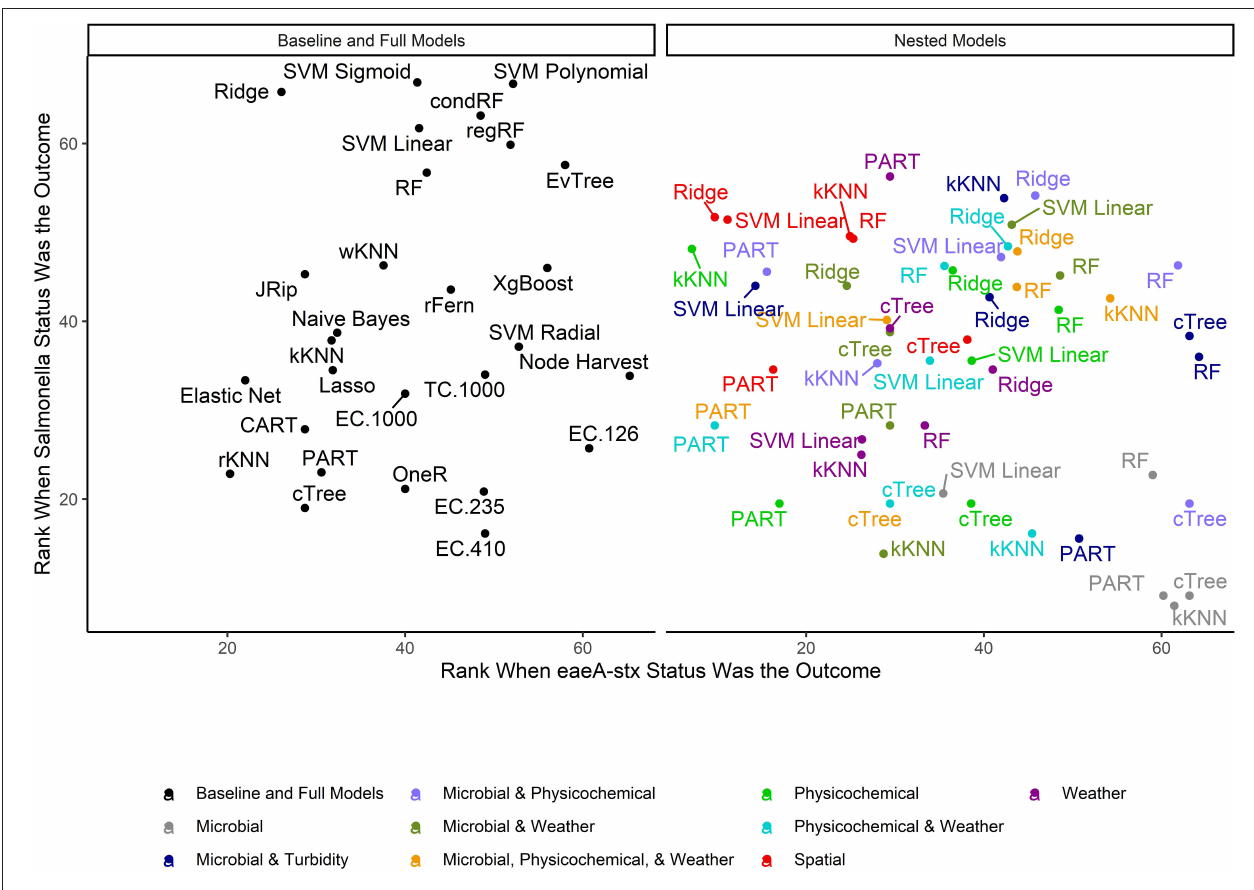
FIGURE 4 | Mean rank (0 = worst; 65 = best) of each learner-data combination for each outcome. To facilitate readability, full and baseline models are depicted in a separate facet from the nested models, which were built using a subset of features. For baseline models, the letters refer to the organism the cutoff is based on (EC = E. coli , TC = total coliforms), and the number refers to the cut-off value (e.g., EC.126 is based on a cut-off of 126 MPN of E. coli /100-mL). Models that were able to accurately predict both Salmonella and eaeA-stx presence appear in the top right corner of each facet, while poor performing models appear in the bottom left of each